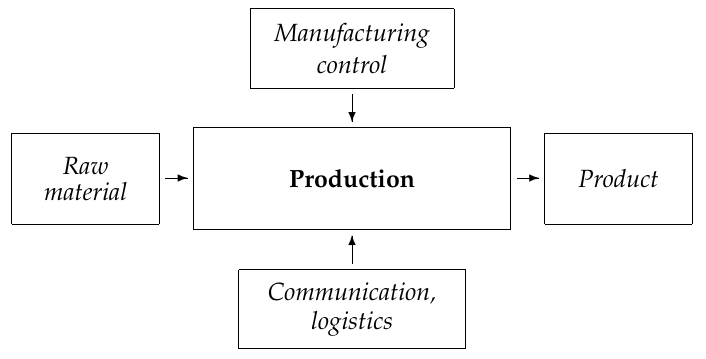
Figure 4. Production model of